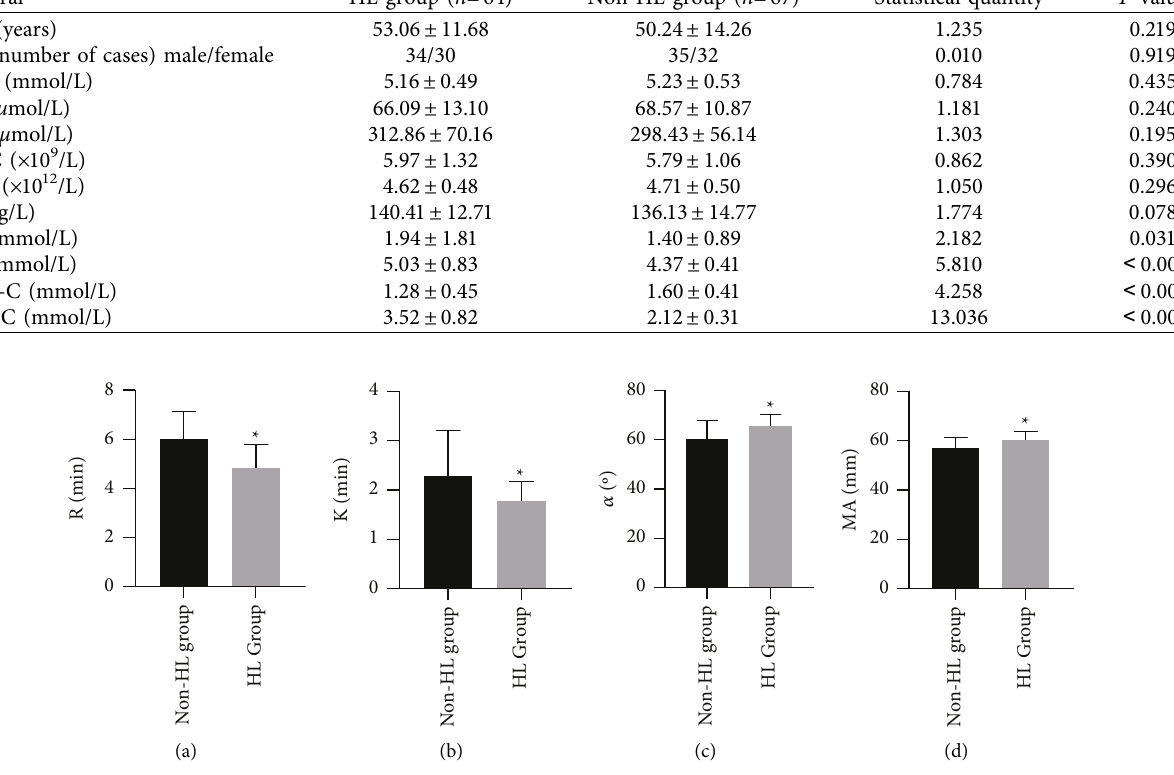
Figure 1: Comparison of various parameters of TEG. Note: ∗ indicates P < 0 .